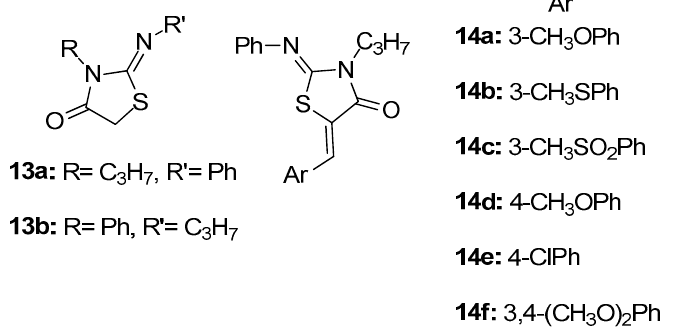
Figure 16. Chemical structures of 2-imino-4-thiazolidinone derivatives 13a , 13b and 5-arylidene-2-imino-4-thiazolidinone derivatives 14a – 14f .